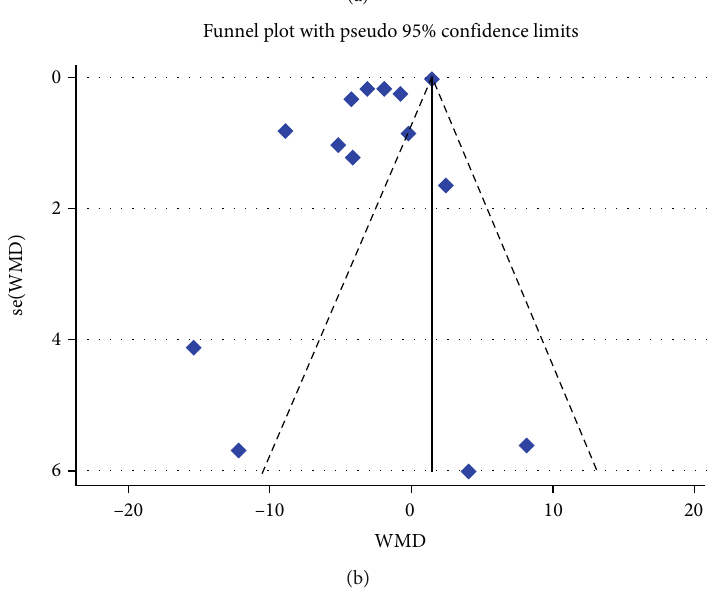
Figure 7: Funnel plot detailing publication biases in the studies included in the meta-analysis; (a) hs-CRP and (b)